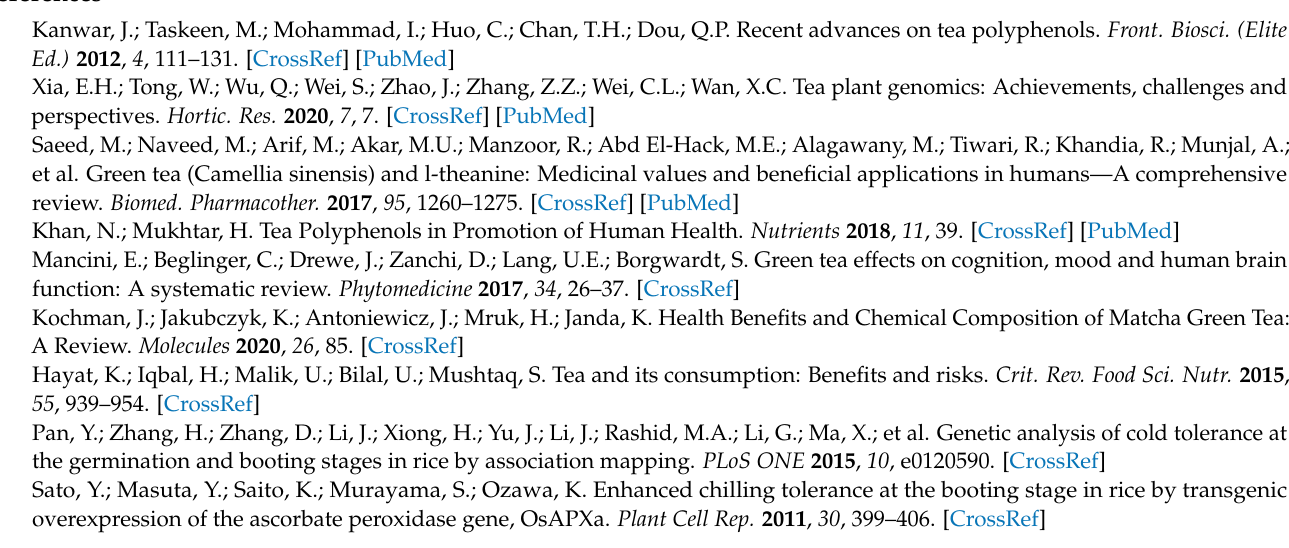
PCR. Table S2: Differential expressed genes analysis in T-4 vs. T-CK comparison. Table S3: Differential expressed genes analysis in T-A vs. T-CK comparison. Table S4: Differential expressed genes analysis in T-A-4 vs. T-4